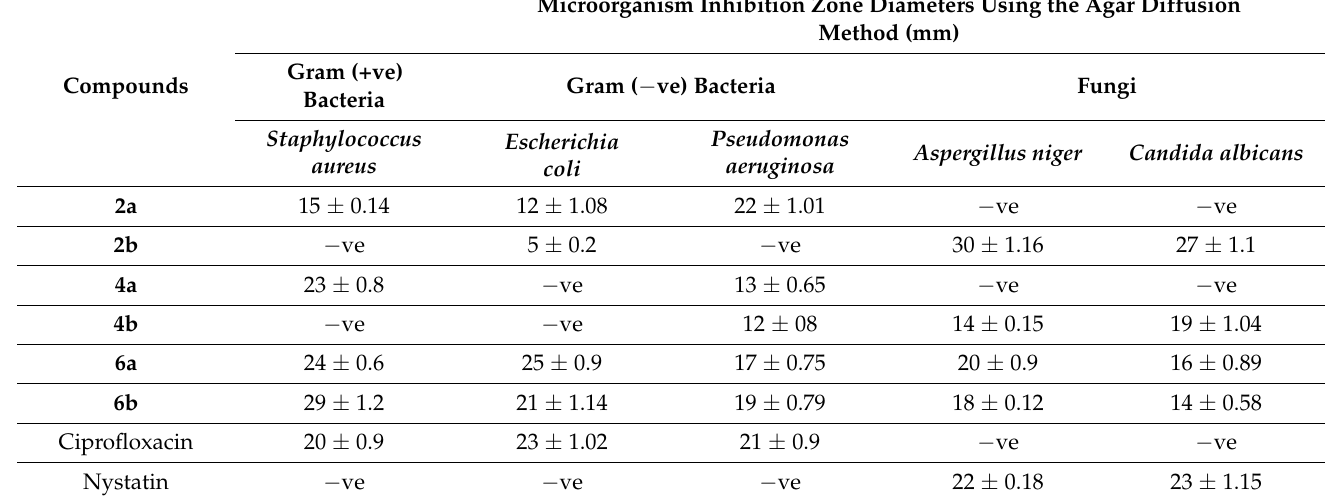
Table 3. In vitro antimicrobial screening of the newly synthesized derivatives using the agar diffusion method.